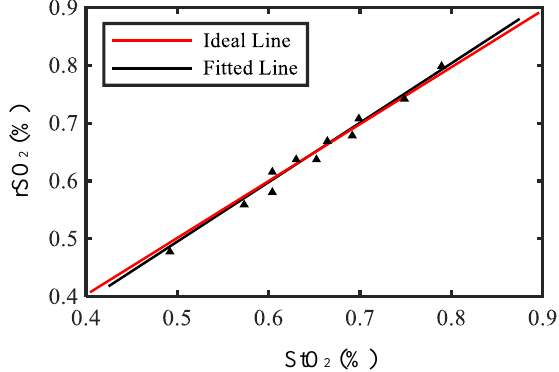
Figure 6. The calibration result of the system.